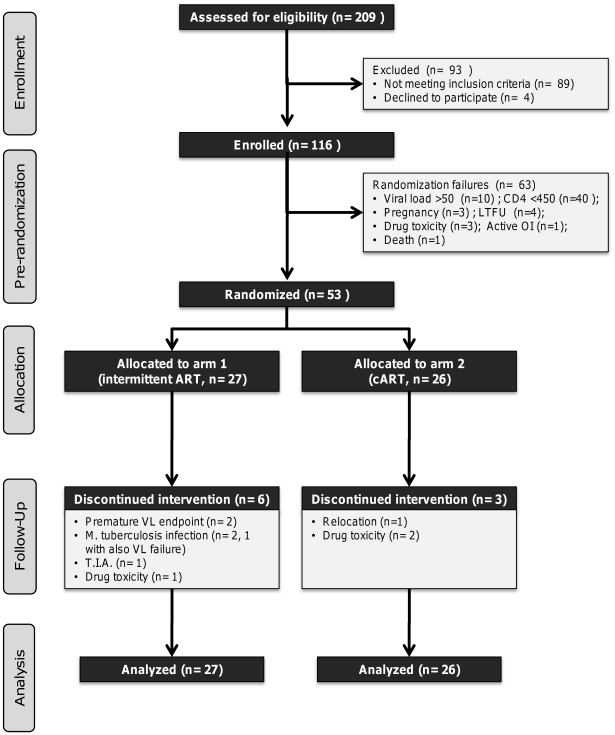
Subject disposition chart.Information regarding subject disposition during the trial is presented according to CONSORT guidelines (http://www.consort-statement.org). Abbreviations used in this table: LTFU: lost to follow-up; O.I.: opportunistic infection; T.I.A.: transient ischemic attacks.